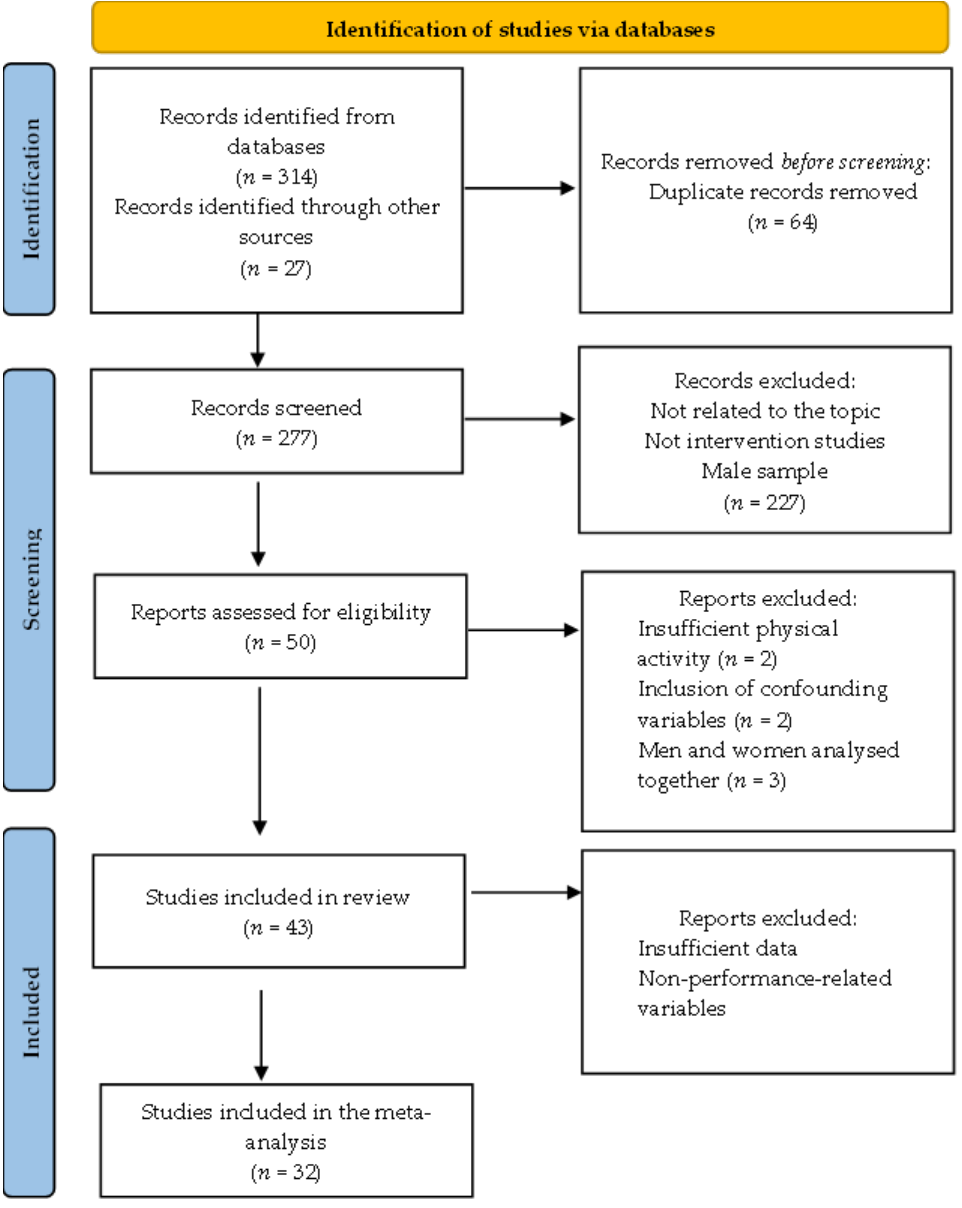
Figure 1. Flow chart for study selection according to PRISMA criterion .